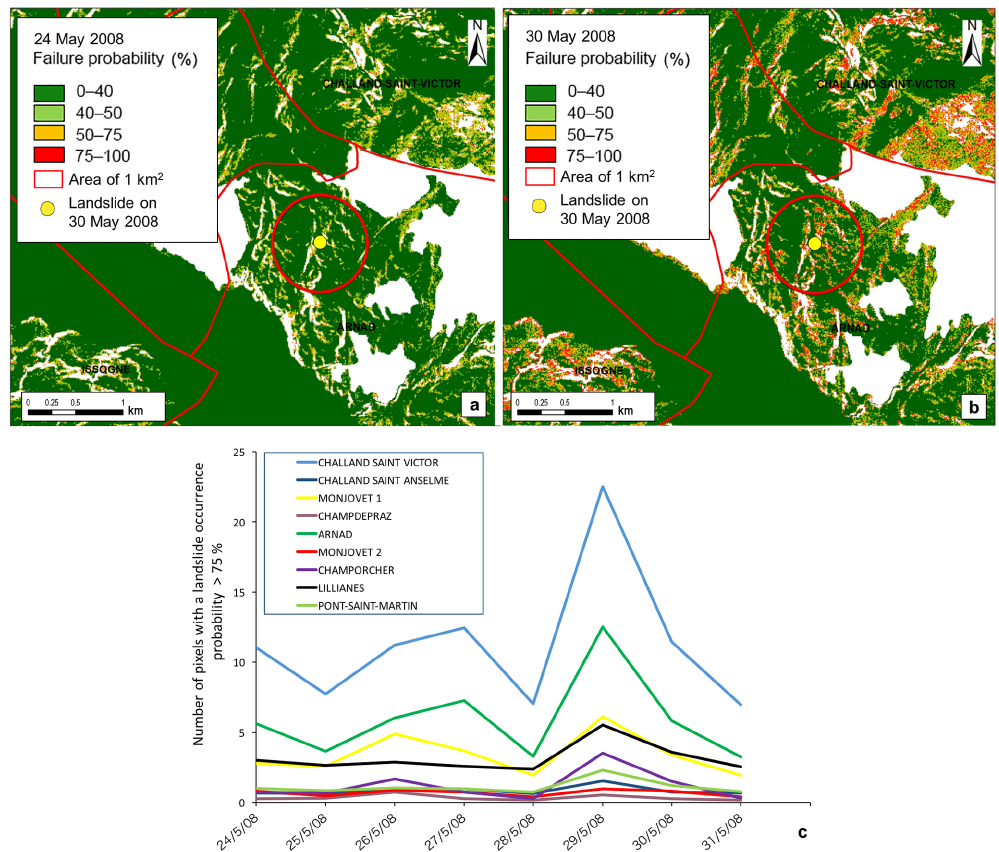
Figure 11. An example of a landslide event that occurred in the Arnad municipality compared to a landslide occurrence probability map, (a) before and (b) after a rainfall event. (c) The number of pixels above 75% failure probability calculated by the model for all the landslides triggered during the event in the study